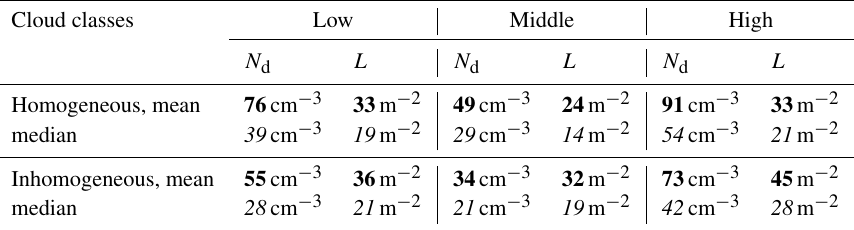
Table 1. Average (bold) and median (italic) values of N d and L for the six particular cloud classes derived from their PDFs (Fig. 4). Cloud classes Low Middle High N d L N d L N d L Homogeneous, mean 76 cm − 3 33 m − 2 49 cm − 3 24 m − 2 91 cm − 3 33 m − 2 median 39 cm − 3 19 m − 2 29 cm − 3 14 m − 2 54 cm − 3 21 m − 2 Inhomogeneous, mean 55 cm − 3 36 m − 2 34 cm − 3 32 m − 2 73 cm − 3 45 m − 2 median 28 cm − 3 21 m − 2 21 cm − 3 19 m − 2 42 cm − 3 28 m −